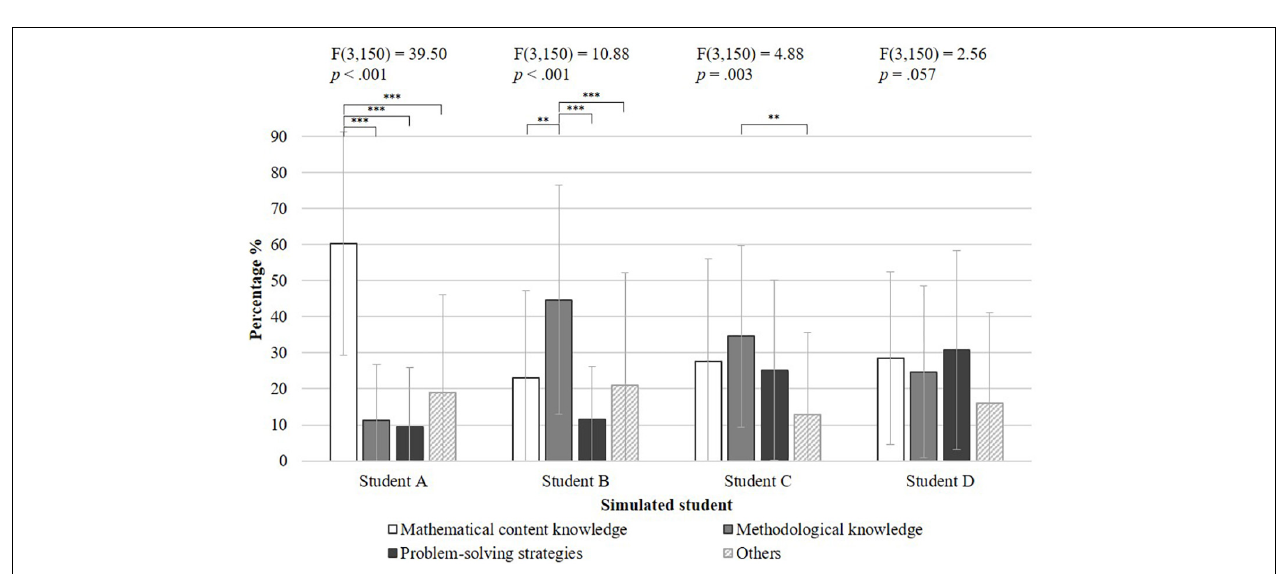
FIGURE 4 | The noticed content of the assessment texts with the following significance levels: * p < 0.05; ** p < 0.01; *** p < 0.001.